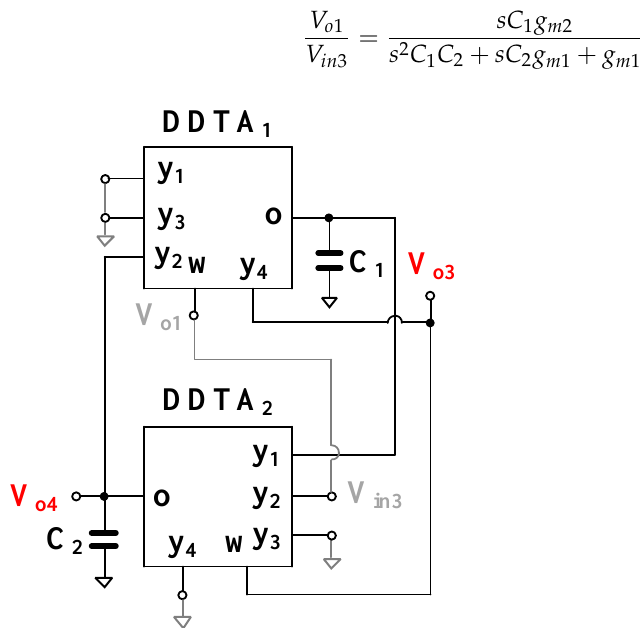
Figure 5. The quadrature oscillator.